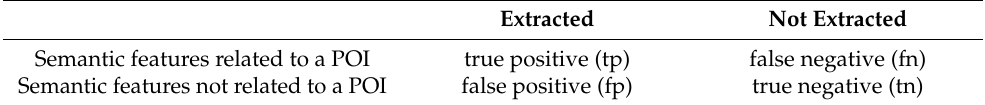
Table 3. Batu Caves corpus statistics. Parameter Value Texts 70 Contexts 68 Words 999 Lemmas 887 Occurrences 3296 Threshold